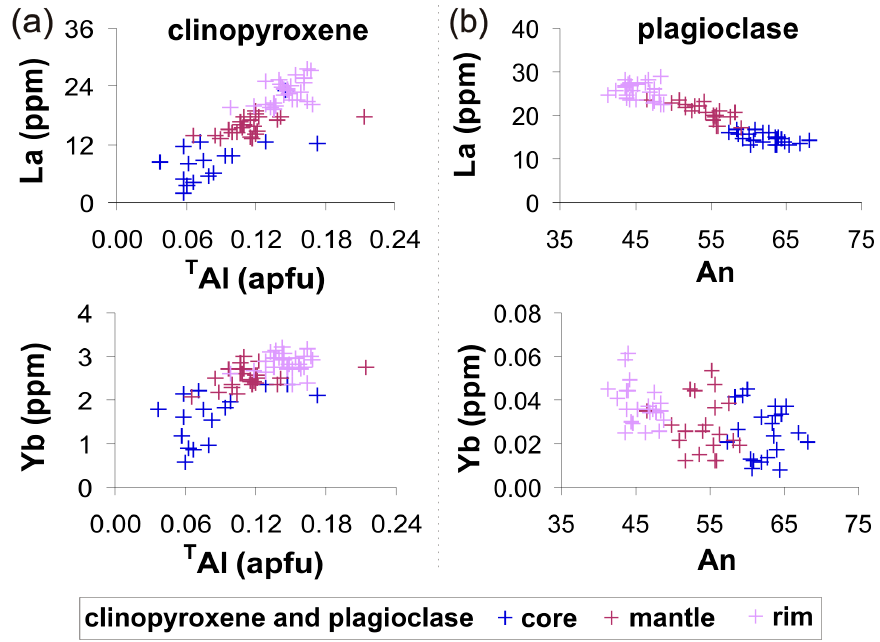
Figure 10. Geochemical evolution of La and Yb concentrations in phenocrysts plotted versus T Al in clinopyroxene ( a ) and An in plagioclase ( b ).